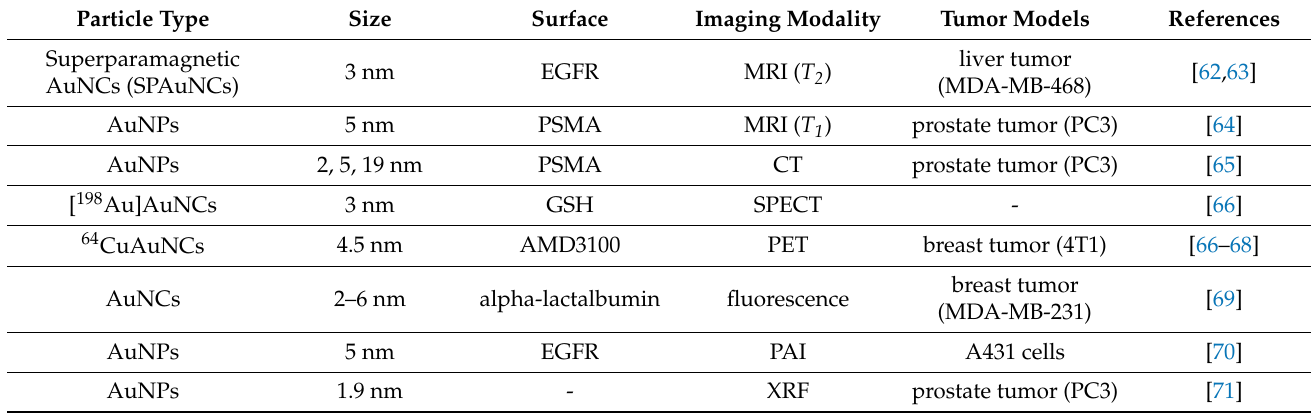
Table 1. Gold nanoparticles as contrast agents for cancer